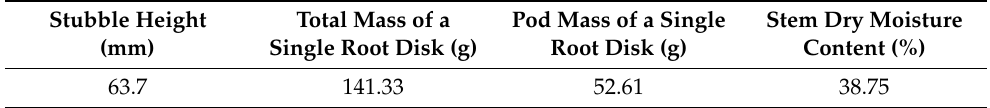
Table 1. Parameters of the peanut root disk.